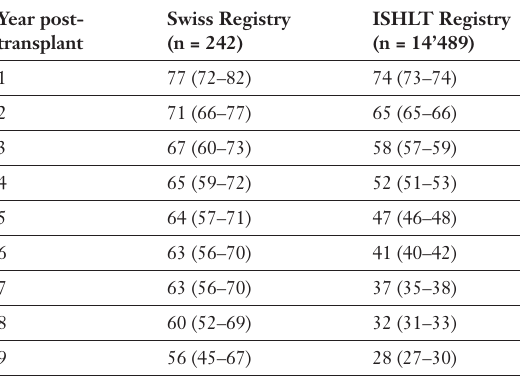
Survival rates of the Swiss cohort com- pared to the data of the ISHLT Registry*.